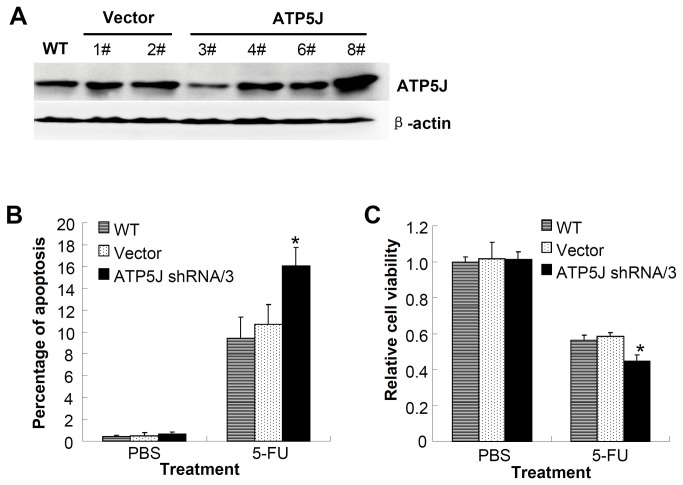
SW620 cells were more sensitive to 5-Fu after knockdown of ATP5J expression.(A) Western blot result for ATP5J protein in different clones of SW620 cell after stable transfection with the same ATP5J shRNA plasmid. (B) Apoptotic ratio of WT, Vector, and ATP5J shRNA/3 SW620 cells after treatment with 50 µmol/L 5-Fu for 3 days. (C) Cell viability assays of WT, Vector, and ATP5J shRNA/3 SW620 cells after treatment with 50 µmol/L 5-Fu for 3 days. Data represent one of two similar experiments. Values represent means ± SD. *P<0.05.